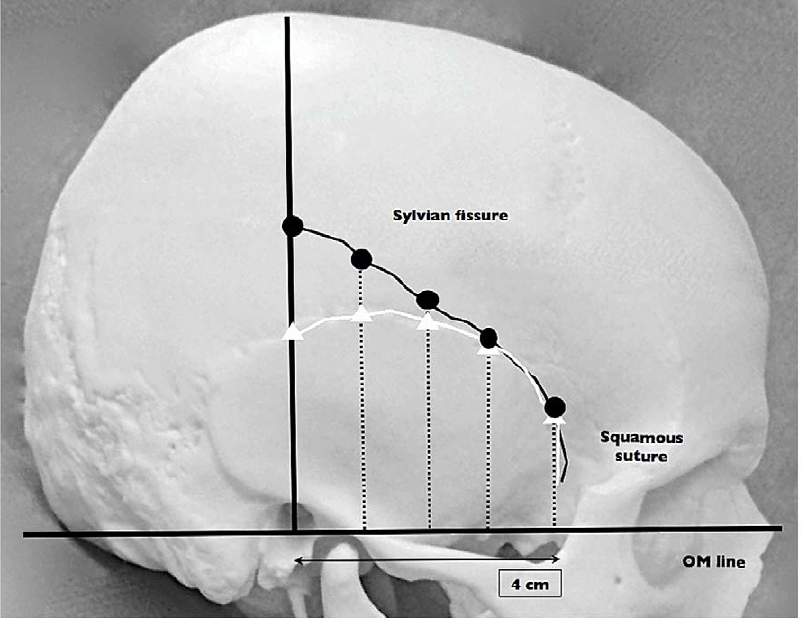
Figure 1. Illustrative methods of measurement. Orbitomeatal (OM) line is drawn to define the base of measurement. Perpendicular line to EAM is drawn, and is regarded as horizontal 0 cm. Curved-black line is showing SF. White line is SS. Dotted lines are showing the measurement points, from 0 to 4 cm anteriorly.